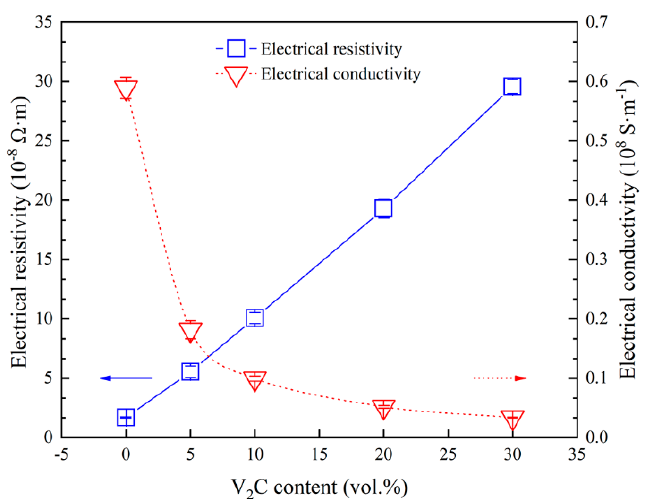
Figure 5. Density of Cu composites as a function of V 2 C content.